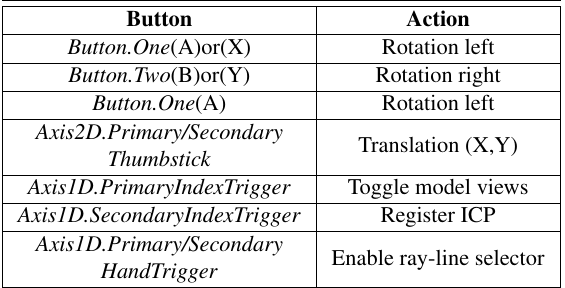
Table 1: Buttons from fragment’s locomotion on the VR environ-